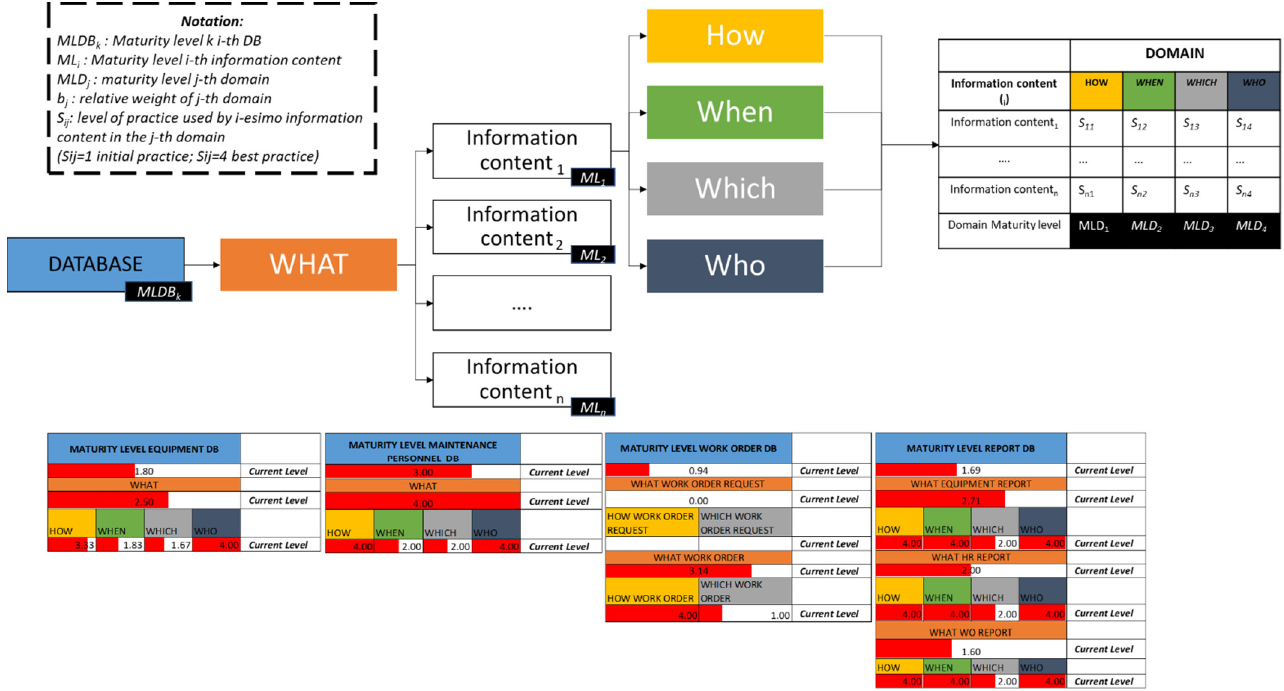
Figure 7. Mathematical formulation and results.